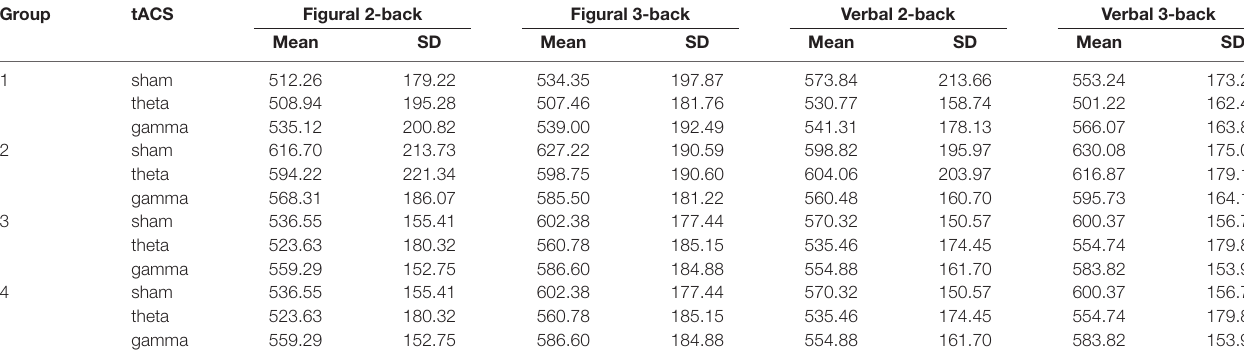
TABLE 5 | Average reaction time (in ms) and standard deviation (SD) on the n-back tasks in sham, theta and gamma tACS sessions for each group. Group tACS Figural 2-back Figural 3-back Verbal 2-back Verbal